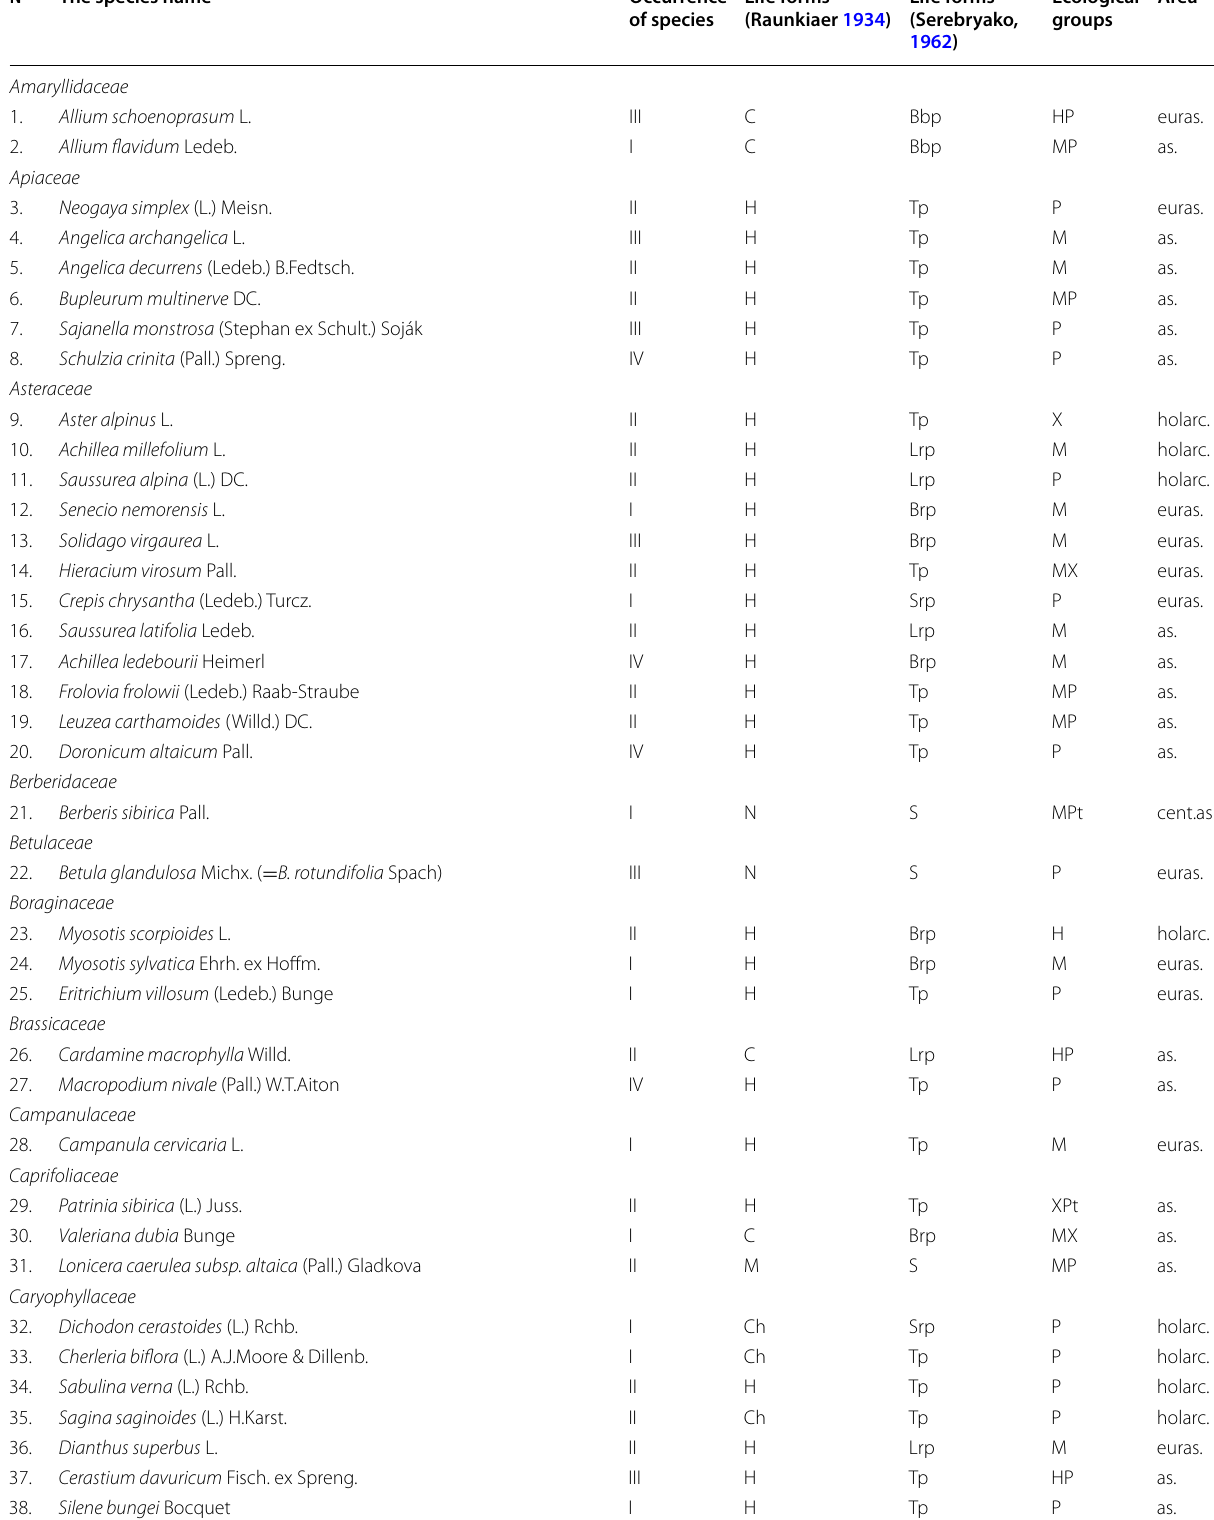
Table 2 Floristic composition of the studied R. rosea study plots № The species name Occurrence